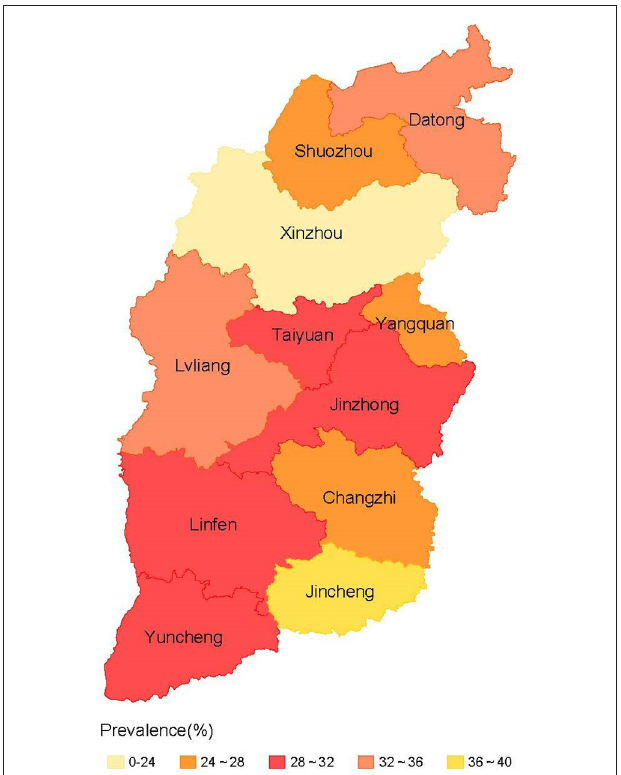
FIGURE 1 | The prevalence of multimorbidity in 11 cities of Shanxi